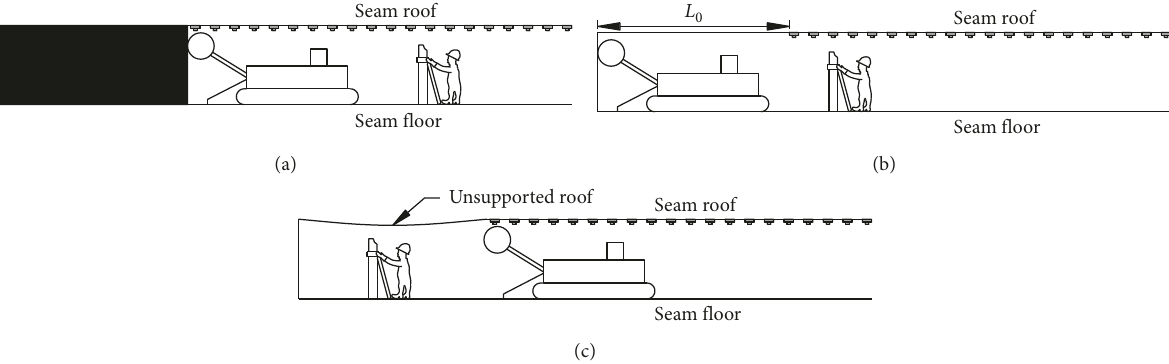
Figure 1: Heading technique consisting of the roadheader and roof bolter. (a) Roadheader starts to excavate. (b) Roadheader finishes a cycle of excavation. (c) The roof bolter is moved close to the coal face to support the newly exposed